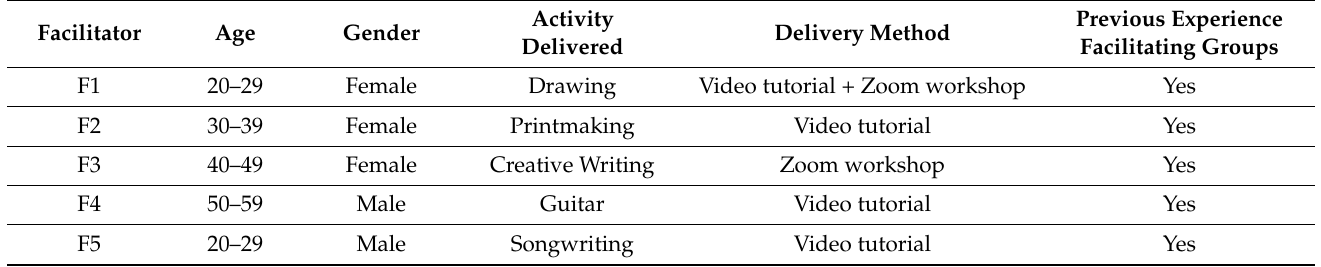
Table 2. Arts Facilitator and Activity